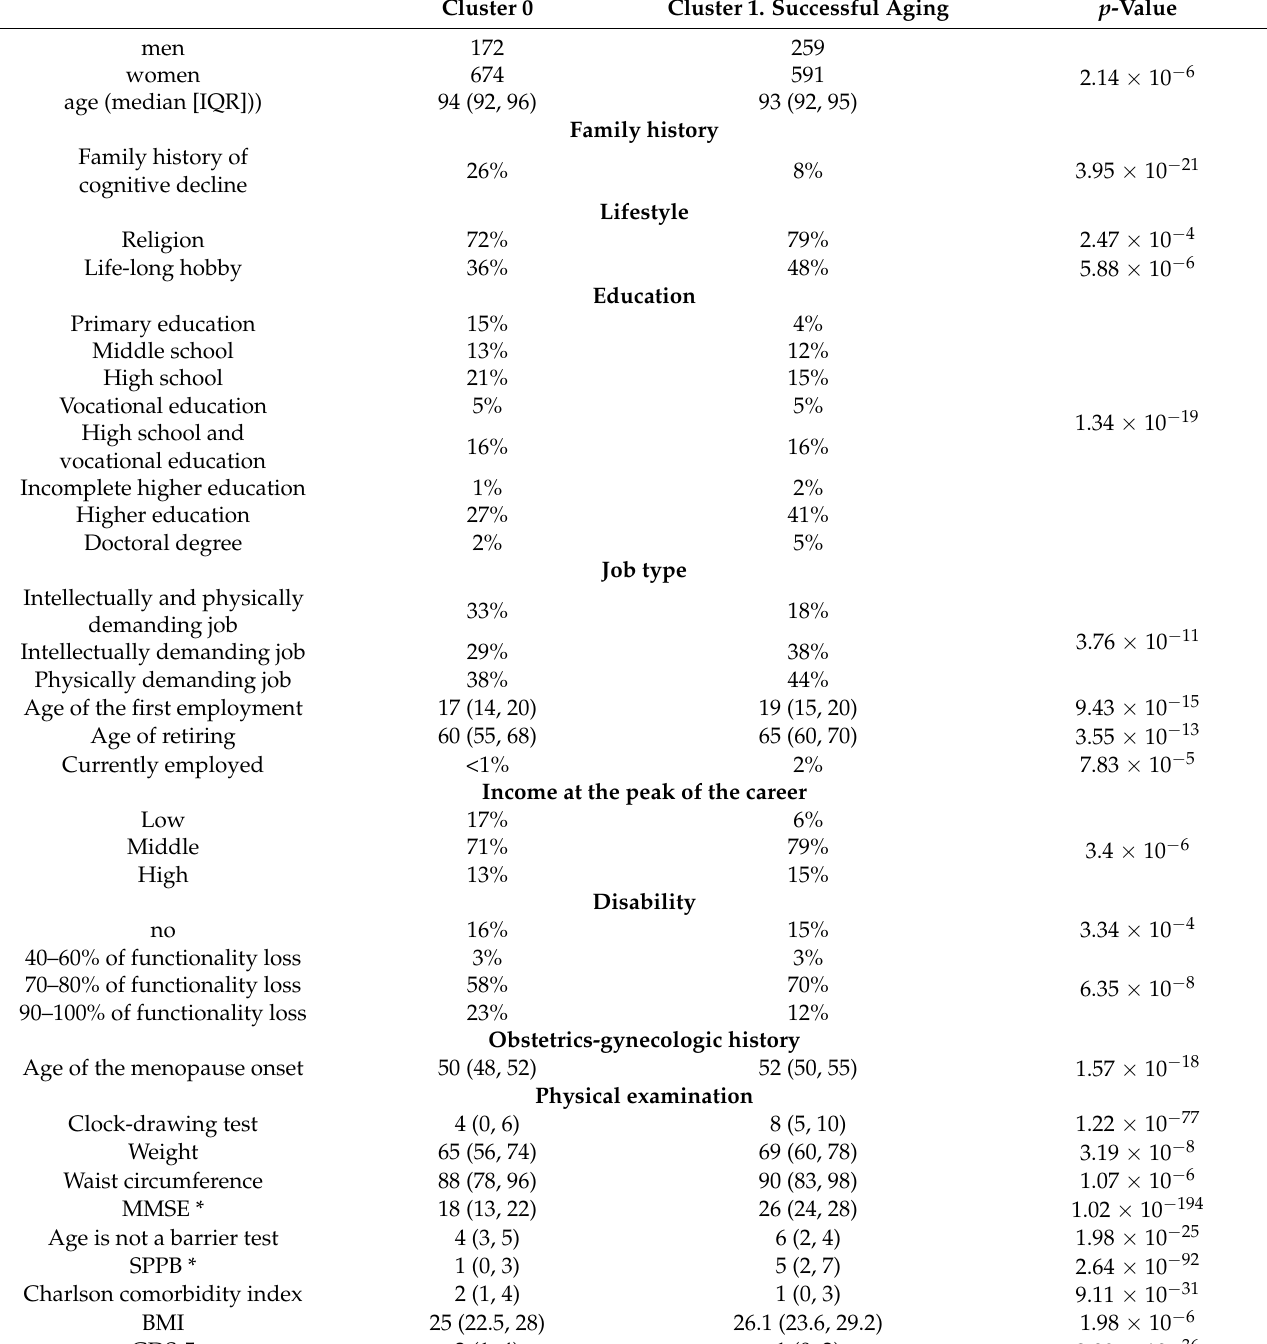
Table 4. Differences in factors (only significant) in the successful aging cluster. Cluster 0 Cluster 1. Successful